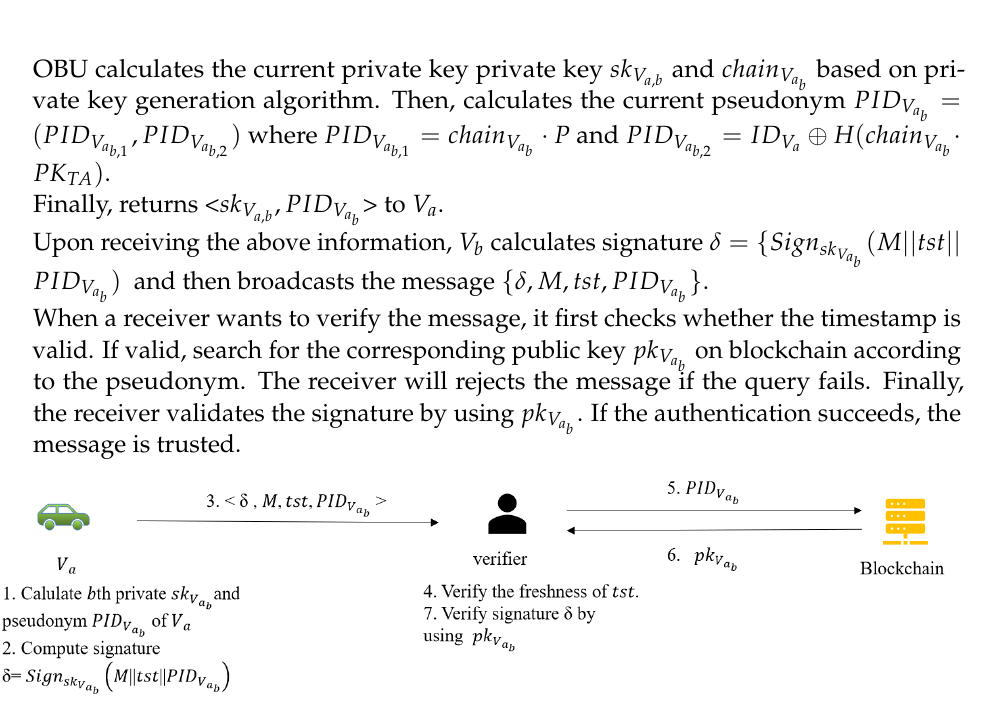
Figure 6. Message authentication